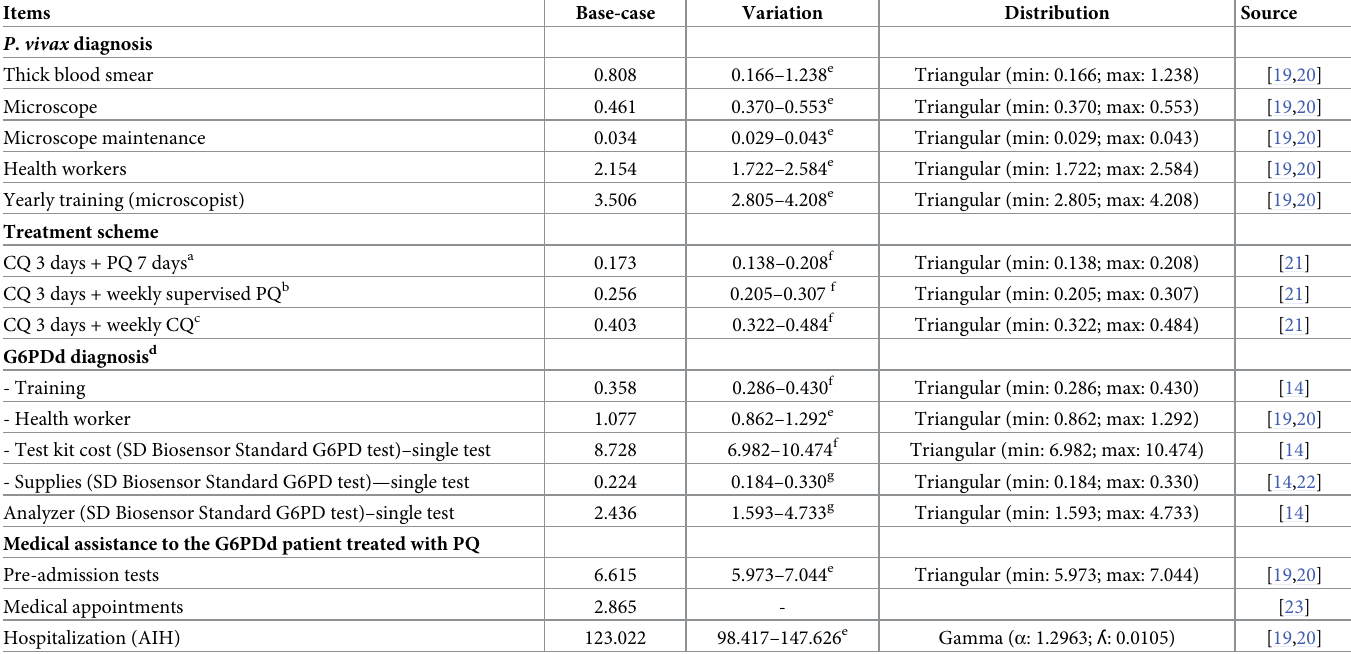
Table 2. Cost components and unit costs considered in the analytical model for the Brazilian Amazon (2020